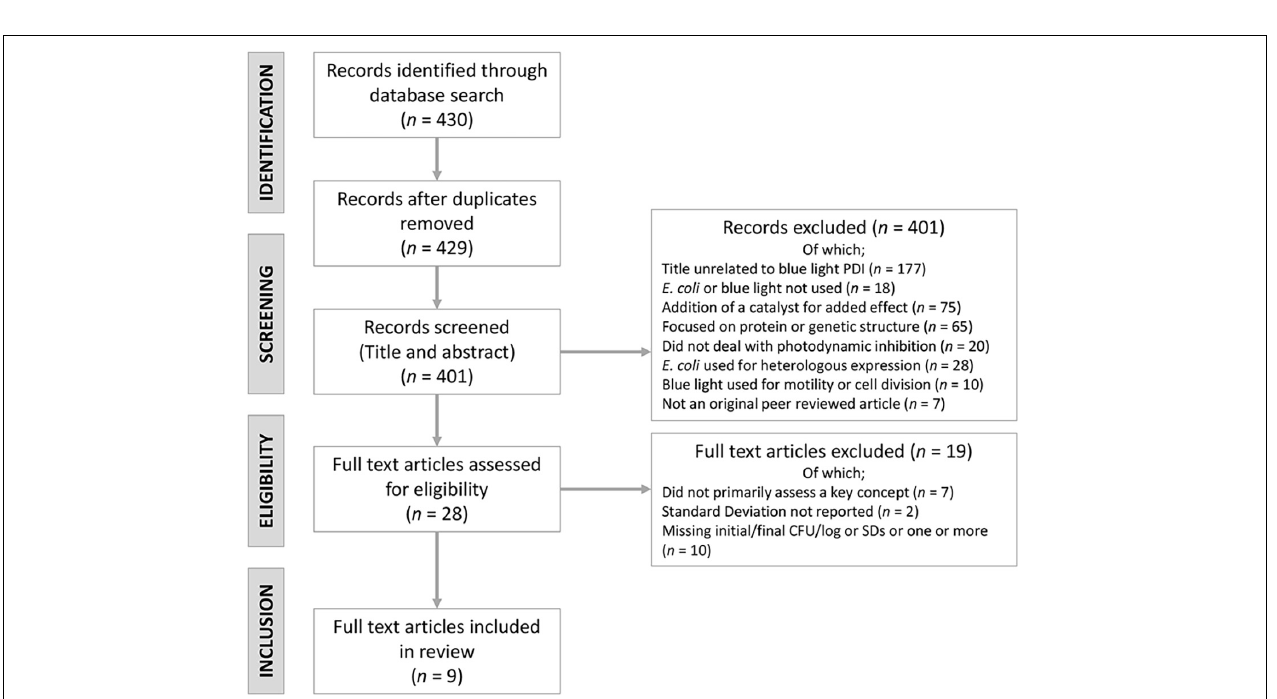
FIGURE 1 | Concept map on interactions between Escherichia coli ( E. coli ) and blue light in the short waved band. Intensity of the blue light source as well as the duration of exposure are critical for the impact on the organism’s physiological responses. The cascade of events evolving as a response to blue light exposure are presented within the orange dotted frame. Biological and environmental factors affecting the cascade of events are placed in gray boxes to the left and right side of the box, respectively.